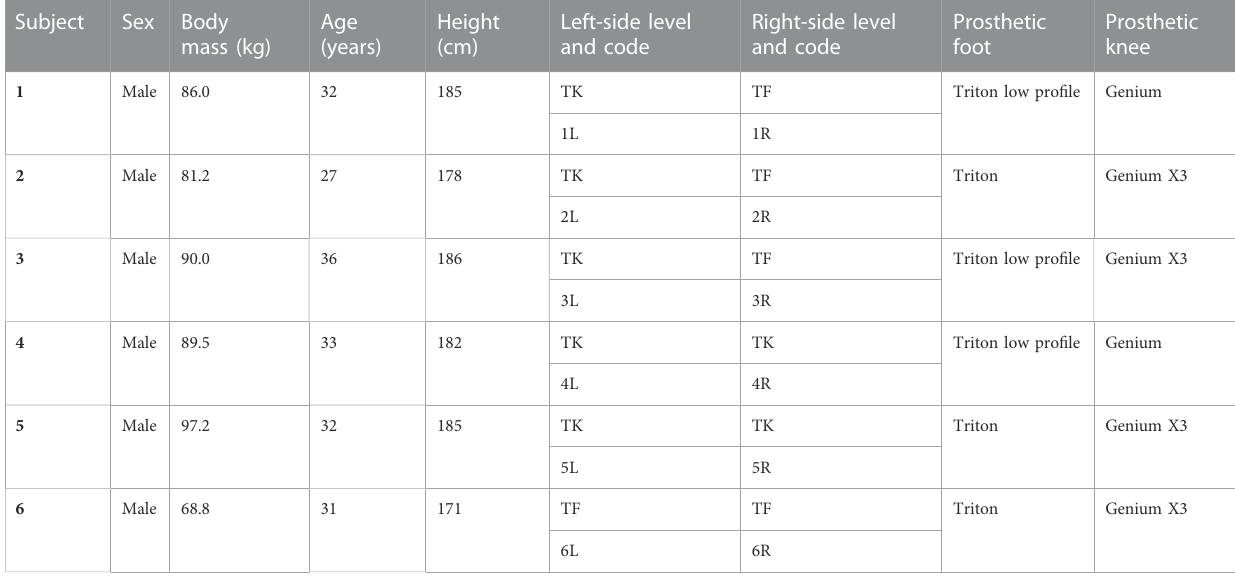
TABLE 1 Bilateral persons with limb loss participant details, TK = through-knee and TF = transfemoral.